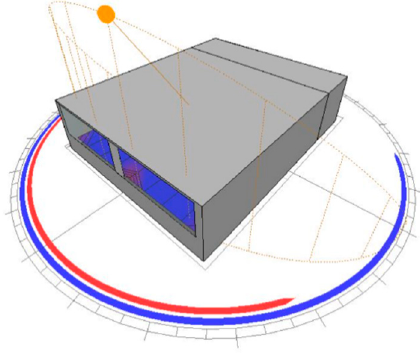
Figure 3. View of the standard classroom.